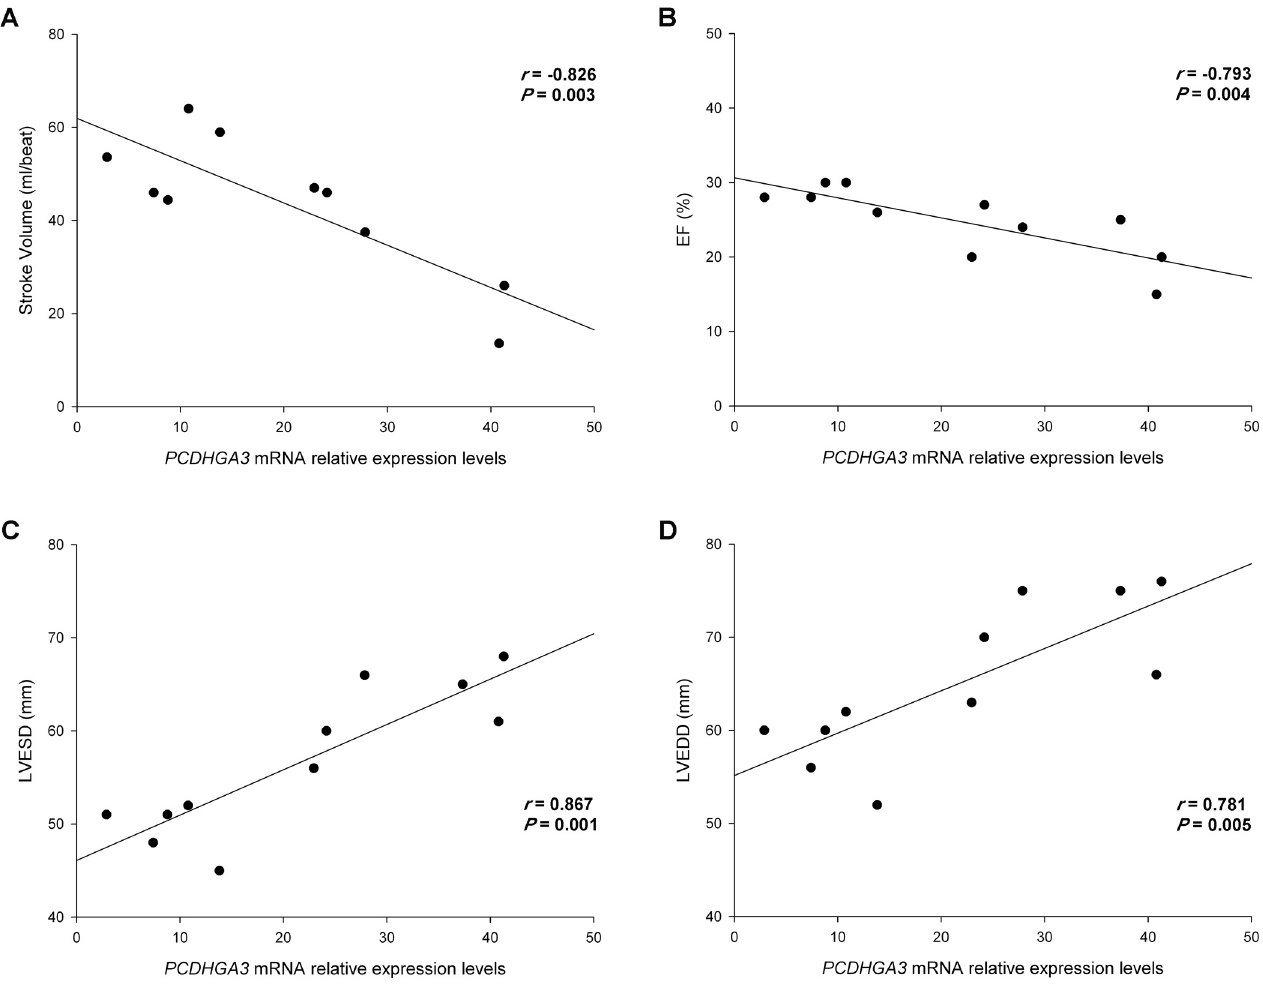
Fig 3. Scatter plots showing the correlations between PCDHGA3 with left ventricular dysfunction and stroke volume in ICM patients. (A) Stroke volume. (B) Ejection fraction (EF). (C) Left ventricular end-systolic diameter (LVESD). (D) Left ventricular end-diastolic diameter (LVEDD). ICM, ischemic